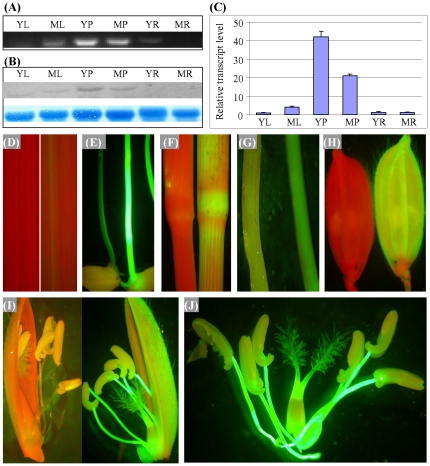
Expression profiles of OsCYP96B4 in rice.The expression analysis was carried out by RT-PCR (A) and was verified by Northern bloting (B) and qRT-PCR (C). In (A) to (C), YL, ML, YP, MP, YR and MR indicate young leaf, mature leaf, young panicle, mature panicle, young root and mature root, respective. (D) to (J) show the expression patterns based on the fluorescent analysis of the OsCYP96B4 promoter-GFP transgenic plants. In (D) to (I), left and right images were taken from WT and the OsCYP96B4 promoter-GFP transgenic plants, respectively. (D) Two-week old leaves; (E) Geminated seeds; (F) Stem nodes; (G) Roots from two-week old seedlings; (H) Florets from nonflowering panicles; (I) and (J) Opened florets.